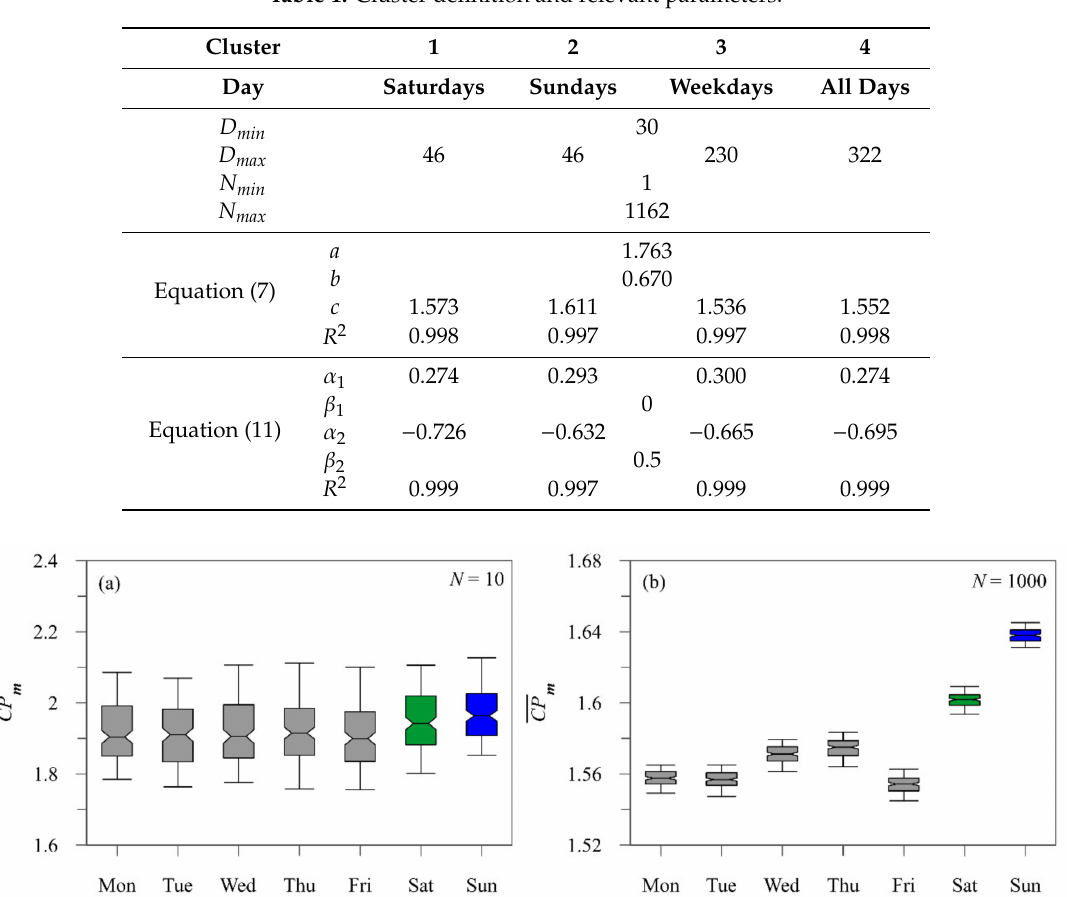
Figure 3. Box-plot of hourly peak factor sample means for the di ff erent days of the week and for two di ff erent numbers of aggregated households: ( a ) N = 10 and ( b ) N =